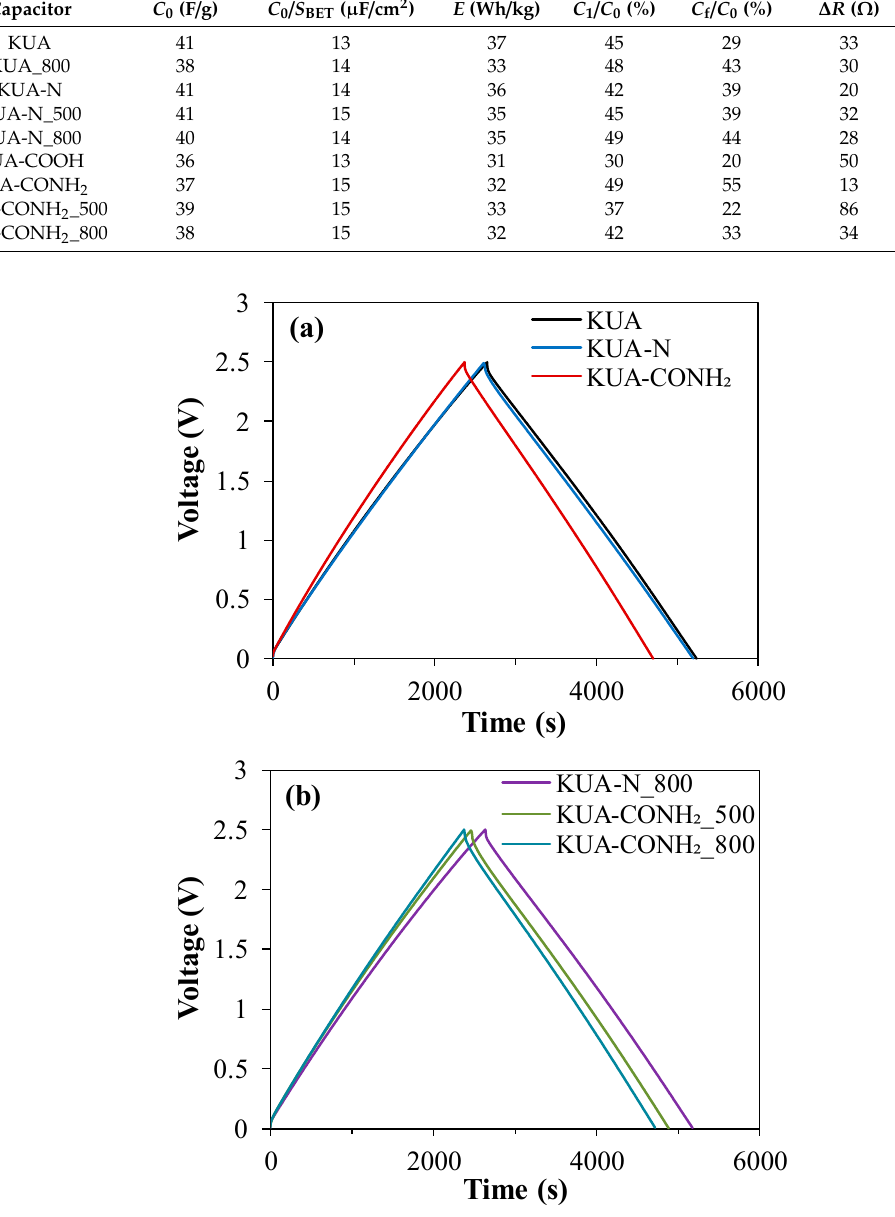
Figure 5. GCD curves obtained for selected EDLCs (activated carbons-based symmetric capacitors): ( a ) KUA, KUA-N and KUA-CONH 2 based capacitors; ( b ) KUA-N_800, KUA-CONH 2 _500 and KUA-CONH 2 _800. 1M TEMABF 4 / PC. j = 40 mA / g. V = 2.5 V.